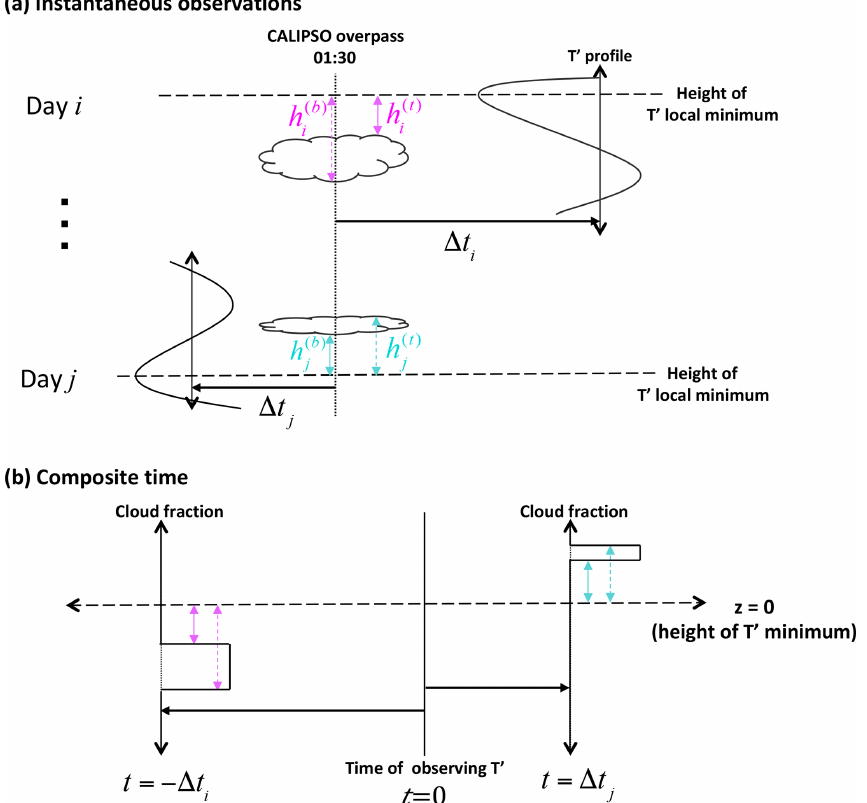
Figure 8. Schematic for creating the composite temporal evolution of cloud fraction with respect to T (cid:48) minima. In this example, as shown in (a) , during day i there is a collocated pair of CALIPSO and RO observations. The RO observation occurs (cid:49)t i hours after that of CALIPSO, and the vertical distance between the height of local T (cid:48) minimum and the cloud top and base is depicted by the dashed and solid magenta lines, respectively, with lengths h (t) and h (b) . In the temporal compositing (b) , in the time bin corresponding to (cid:49)t i hours before observing i i T (cid:48) , the cloud fraction is binned according to how much each vertical bin overlaps with the interval [ h (b) out for the collocated pair at day j . Also see text for